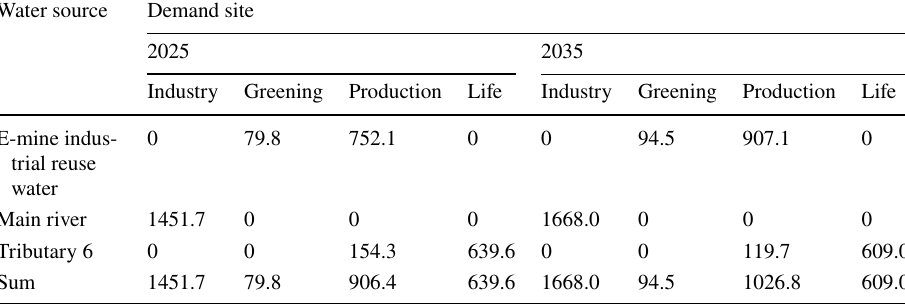
Table 9 Results of water resources allocation in the e-mine area in 2025 and 2035